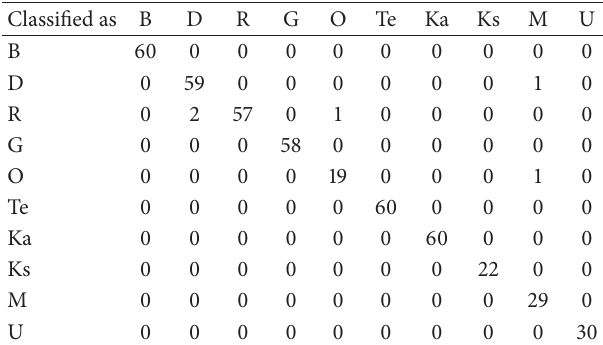
Table 3: Confusion matrix for Simple Logistic classifier where highest accuracy rate was found.